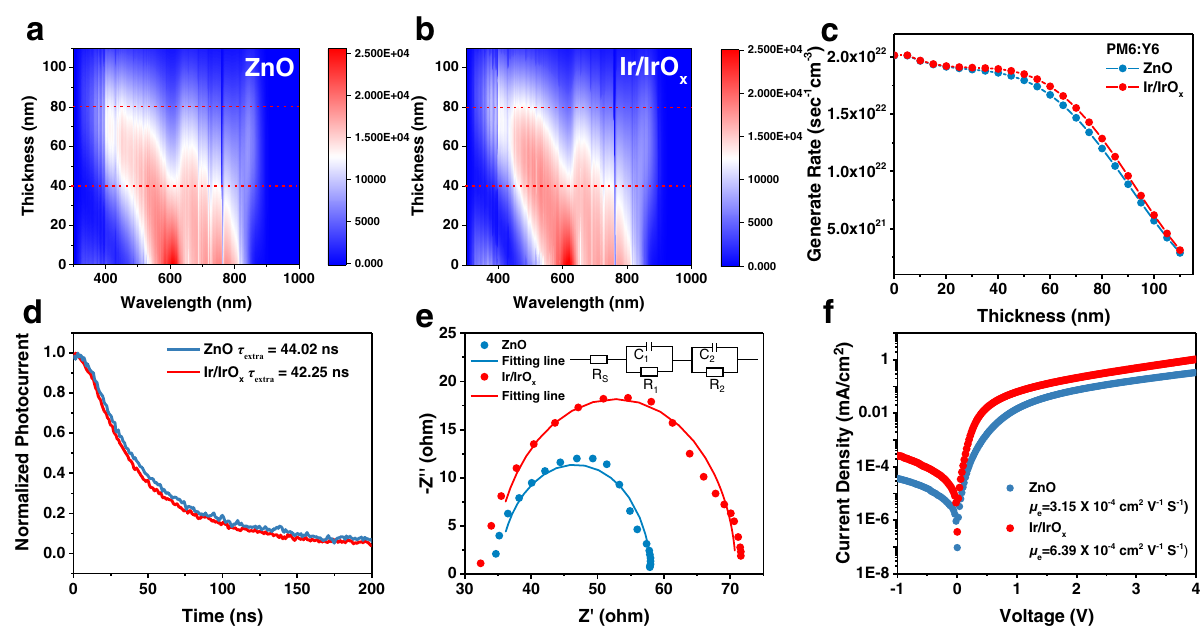
Fig. 3 | Device physics. The optical simulation for the exciton generation rate pro fi lesofBHJ fi lmsinthe( a )ZnO-and( b )Ir/IrO x -basedOSCs. c Theplotofexciton generation rate with the depth of active layer extracted from optical simulations. Transient photocurrent (TPC) plots ( d ) and electrochemical impedance